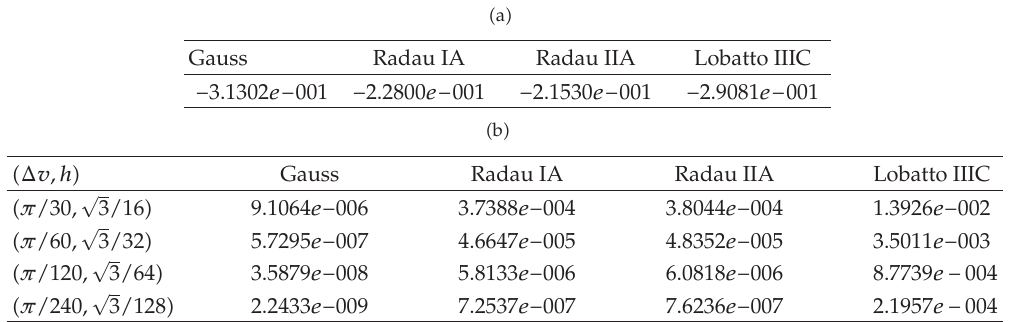
Table 1: (cid:3) a (cid:4) The Γ -values of the methods for (cid:3) 2.23 (cid:4) , (cid:3) b (cid:4) The errors of the numerical solutions of (cid:3) 2.22 (cid:4) by methods (cid:3) 3.7 (cid:4) – (cid:3) 3.10 (cid:4) .